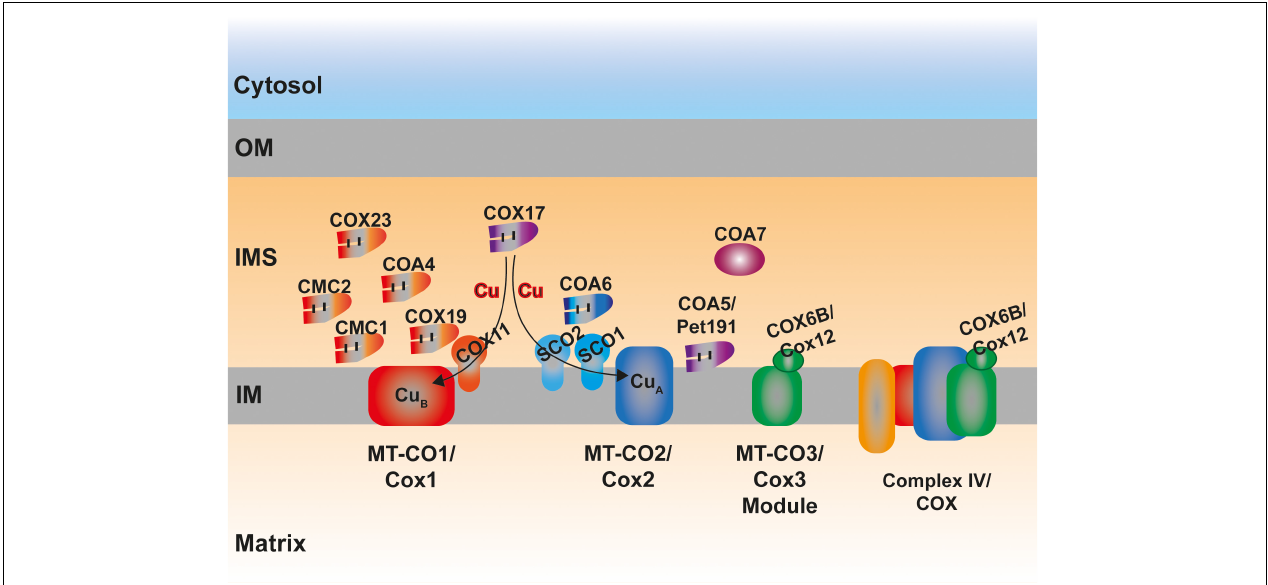
FIGURE 4 | Schematic representation of the MIA40 protein substrates located in the IMS involved in the assembly of complex IV (COX). The proteins involved in the stabilization and metalation of MT-CO1 and MT-CO2 are indicated in red and blue color, respectively. COX17 is the archetypal twin CX 9 C protein, mediating copper (Cu) delivery to the active centers of both MT-CO1 and MT-CO2. The exact molecular role of COA5/Pet191 and COA7 is still unknown. COX6B, Cox12 in yeast, is the only COX subunit fully localized in the IMS.